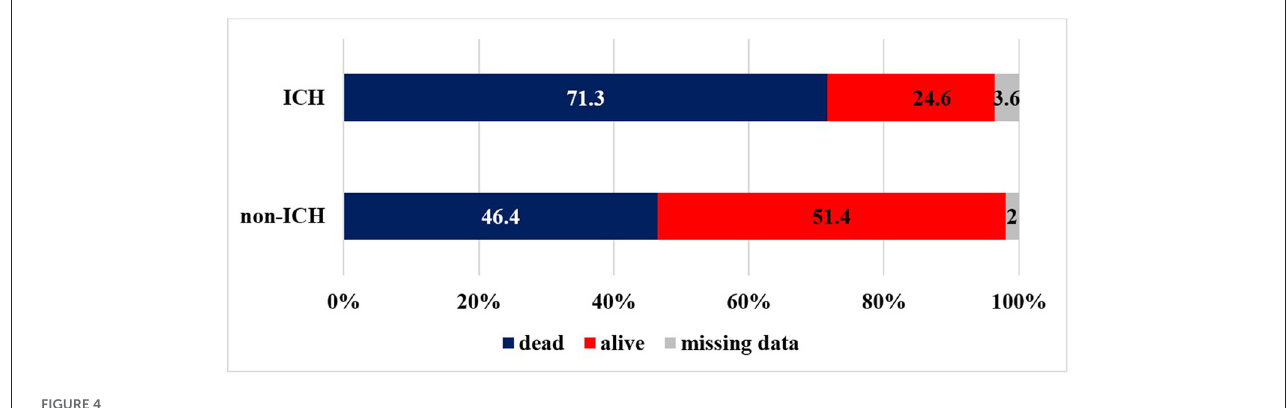
FIGURE4 Mortality at year (ICH, intracranial hemorrhage).